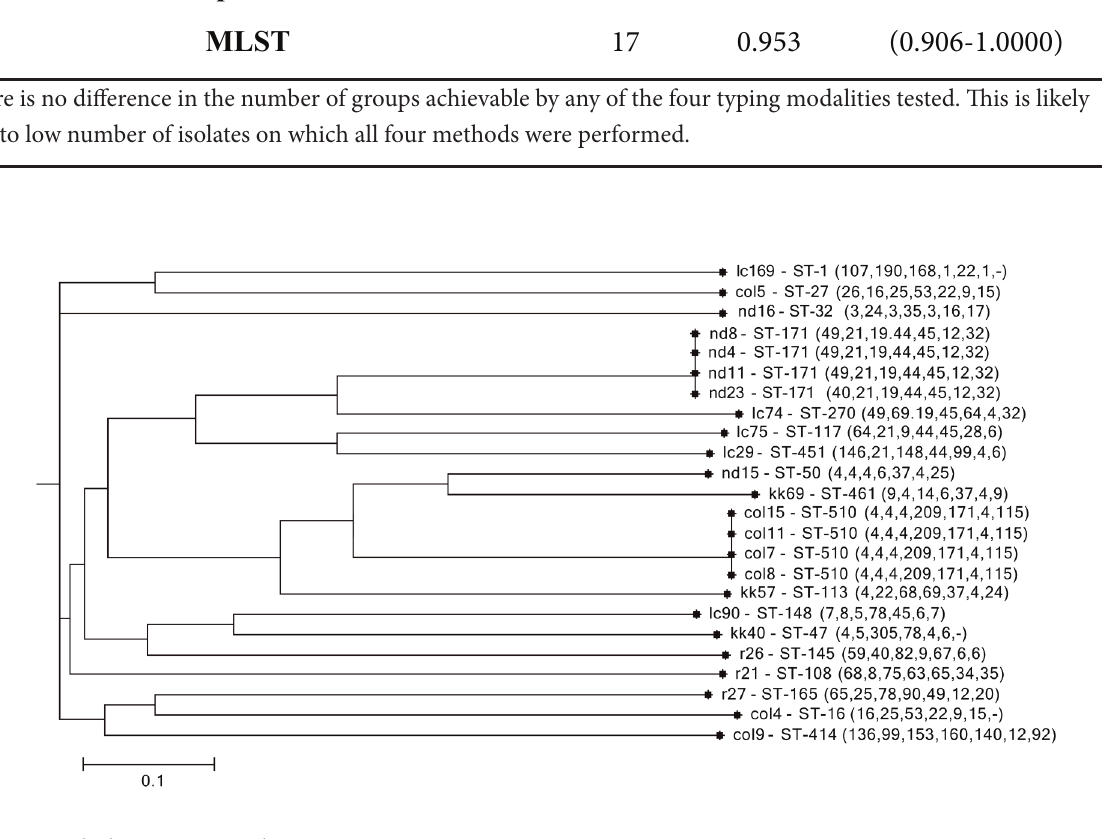
Figure 4. Phylogenetic tree by